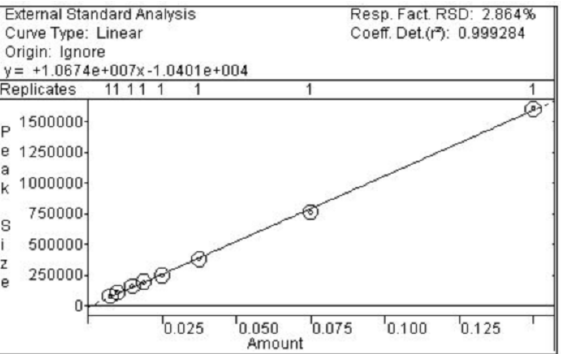
Figure 1. Calibration curve for gallic acid.